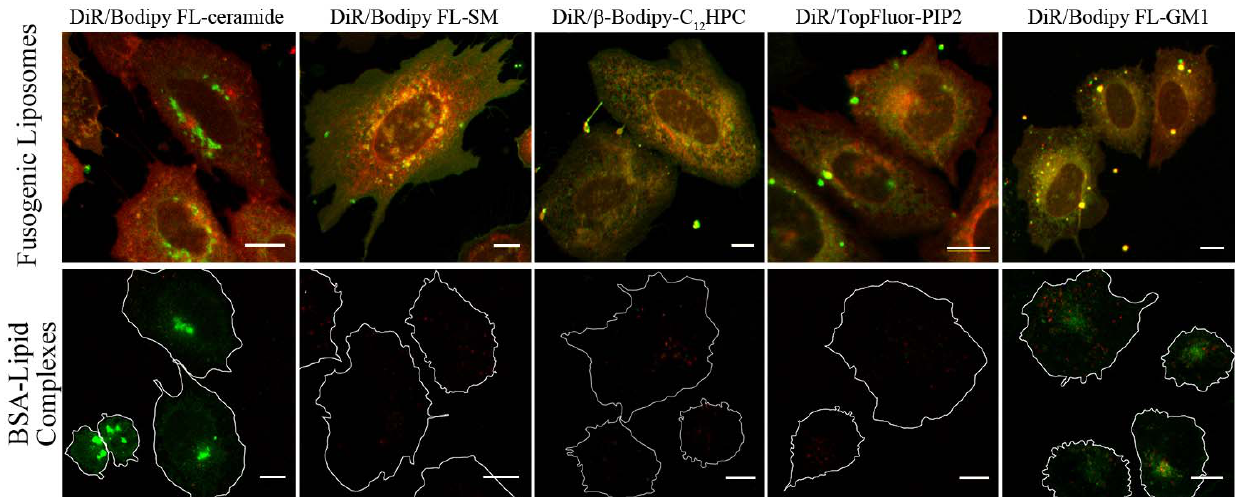
Figure 5. Comparison of lipid incorporation using fusogenic liposomes and BSA